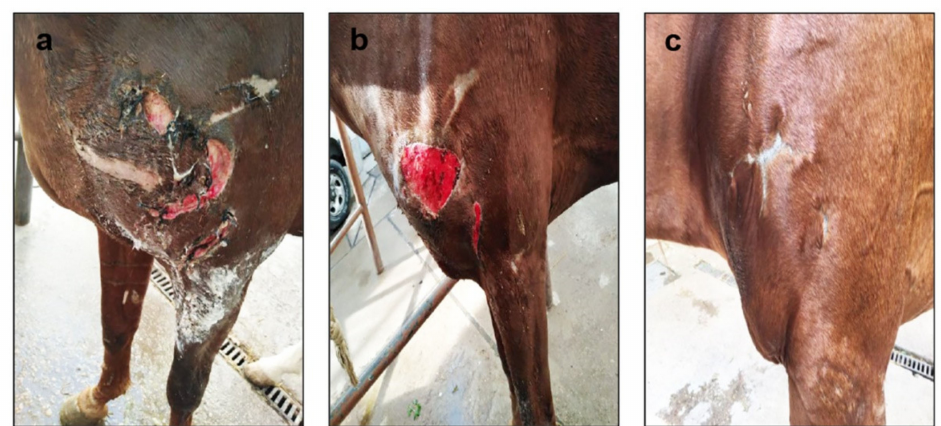
Figure 9. ( a ) Eleven-year-old horse with an old accidental wound nearly at the level of elbow joint of the left forelimb (movable area) after different trials of treatment and suturing showed no tendency for healing with wound dehiscence. ( b ) The same wound after one week of treatment with S. arghel EtOAc gel showed complete epithelization with decreased wound size. ( c ) The wound, after 2 months of treatment, showed complete